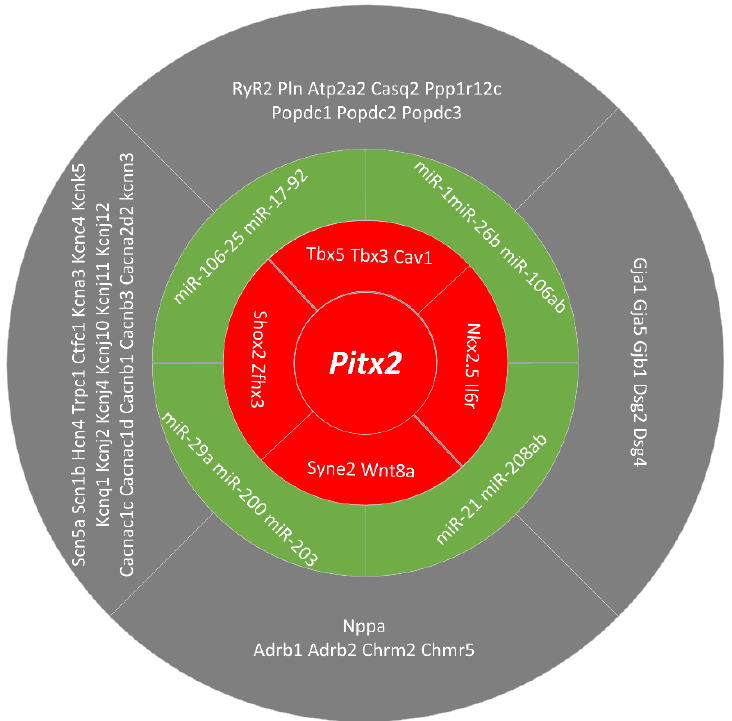
Figure 3. Schematic representation of the PITX2 downstream pathways involved in pro-arrhythmogenic events leading to atrial fibrillation. Multiple lines of evidence demonstrate that PITX2 exerts a pivotal role in regulating the expression of distinct ion channels, cell-cell coupling and beta-adrenergic stimulation. Most of these pathways are modulated by microRNAs which are under the control of PITX2 action [49].